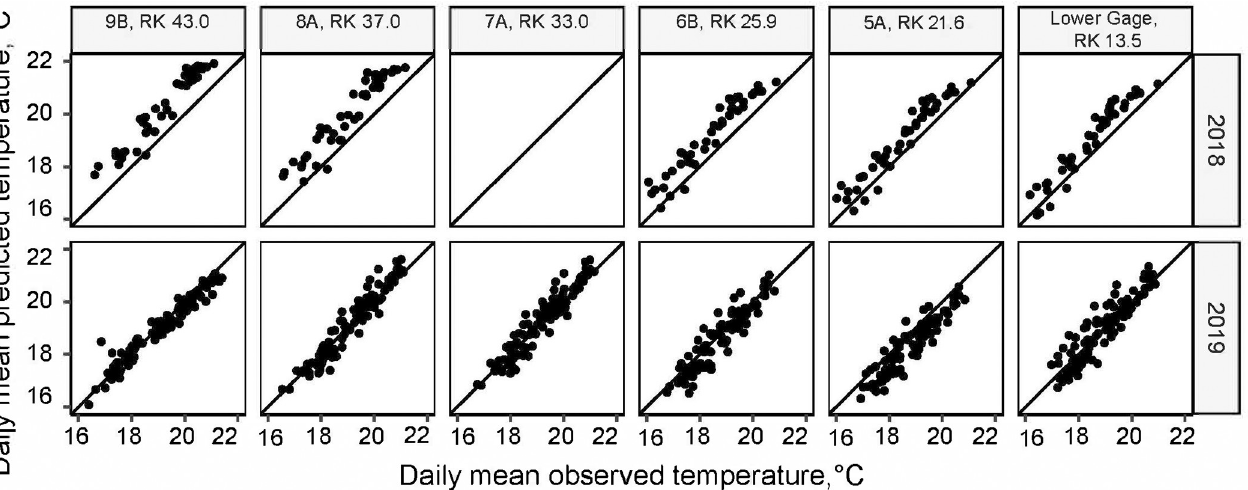
Fig 4. Heat Source model fit. Hourly predicted versus observed temperature values for the final Heat Source model at all monitored temperature locations in 2019 (n = 6) and 2018 (n =